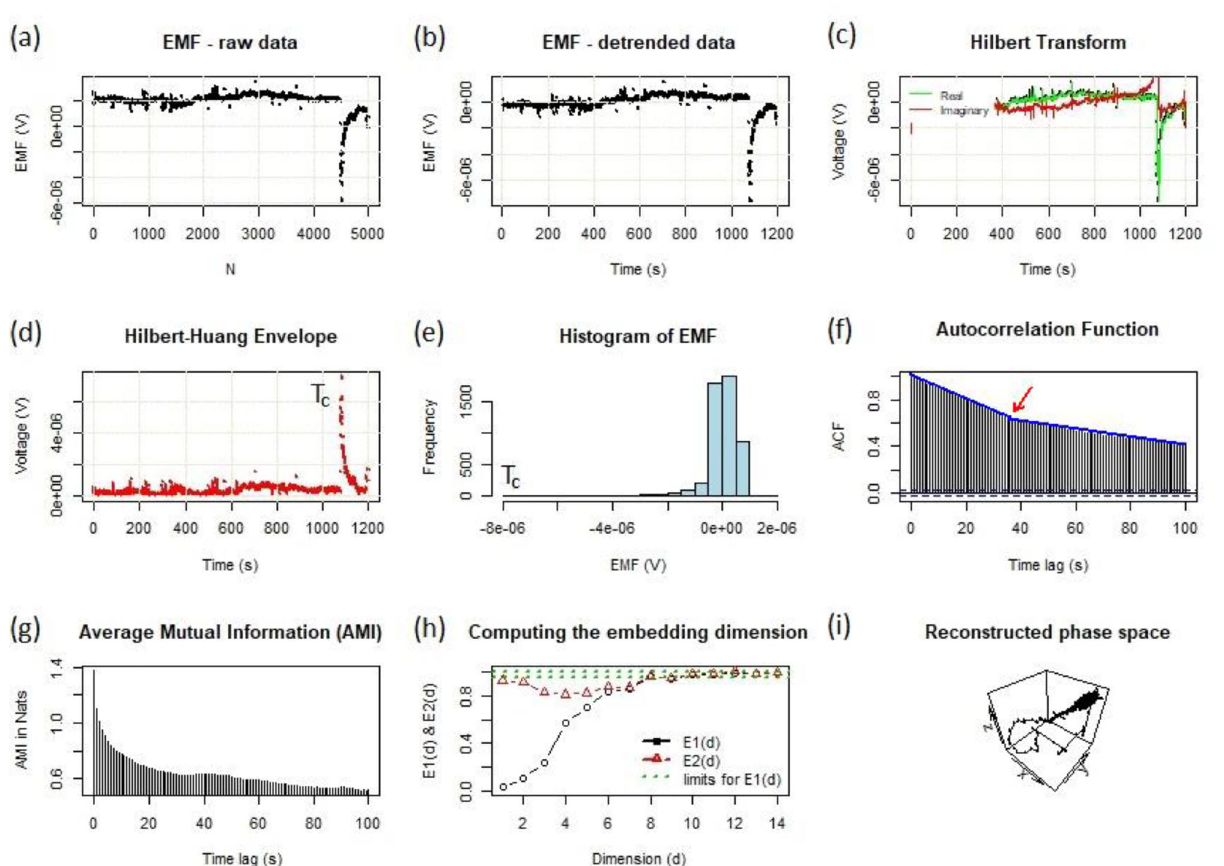
Figure 6. Different complexity measures of the collection of hyacinth pollen tubes at temperatures close to the optimum growth temperature ( T ∼= T c ). The thermal excitation in this dissipative system occurred at the critical point (indicated) when the resonance conditions were met. Note the bilinear character (blue lines of different slope) in panel ( f ), which show a characteristic time delay (red arrow) of approx. 38–40 s, a value that is characteristic of the oscillation of a pollen